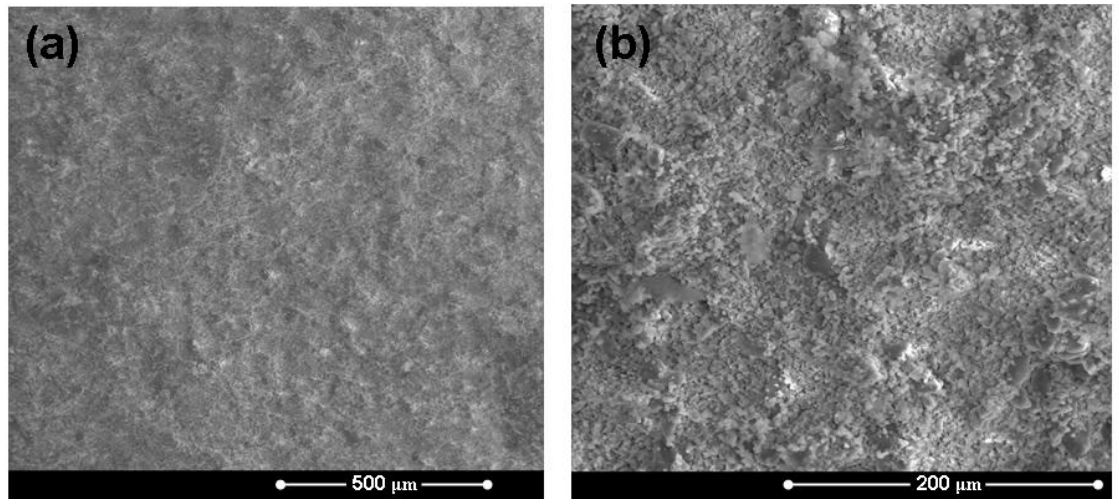
Figure 3. Micrographs of the surface of a HA/BG_Ca sample (different magnification degrees) treated at 750 °C for 3